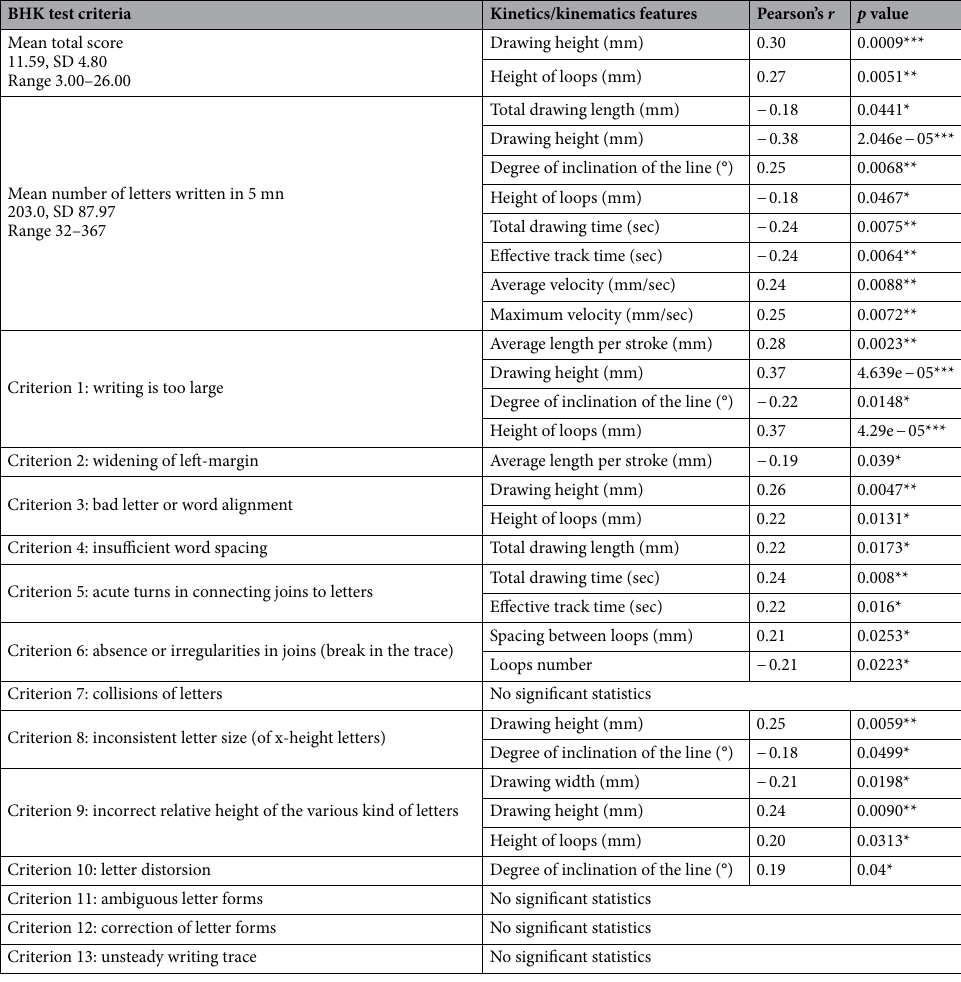
Table 5. Statistical significant correlations between BHK scale scores and spatial–temporal/kinematic measures for the copy of a line of cycloid loops (N = 122). SD standard deviation. *p < 0.05; **p < 0.01; ***p <